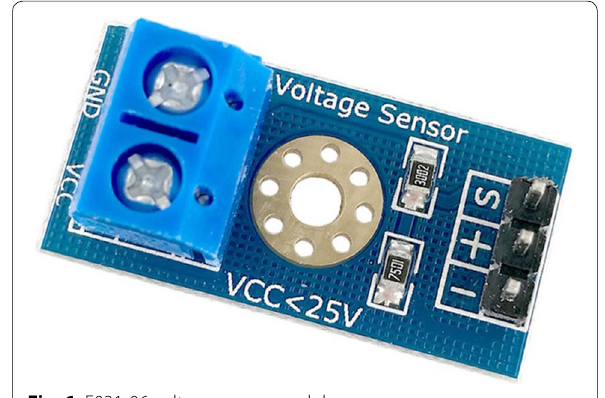
Fig. 6 F031-06 voltage sensor module